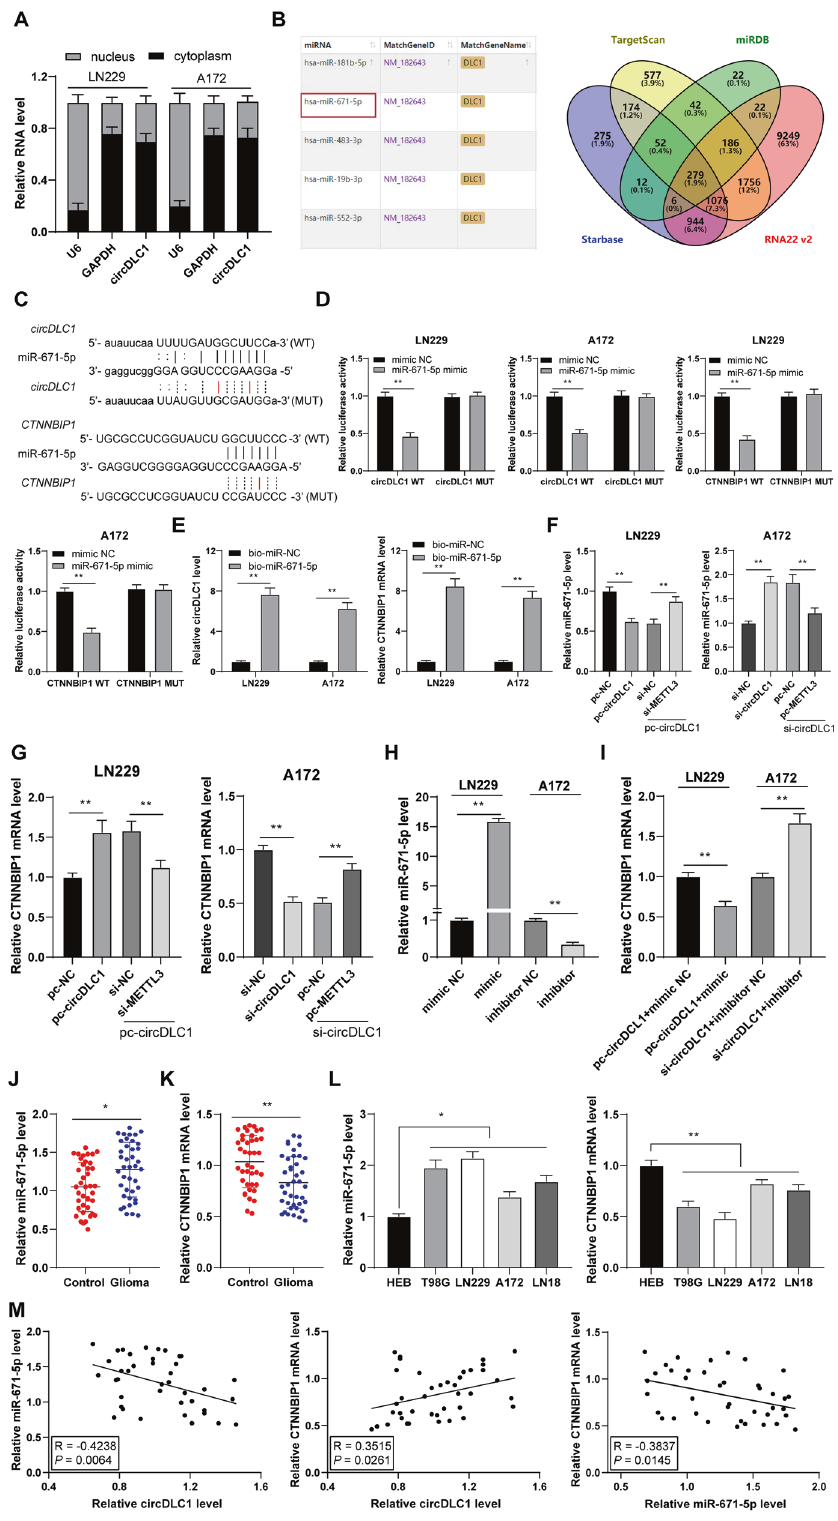
( p < 0.01, Fig. 7D – E), elevated m6A level and circDLC1 expression ( p < 0.01, Fig. 7F – G), reduced miR-671-5p expression ( p < 0.01, Fig. 7H), and enhanced CTNNBIP1 expression ( p < 0.01, Fig. 7I). Brie fl y, METTL3 suppressed glioma cell malignant proliferation via the circDLC1/miR-671-5p/CTNNBIP1 axis in